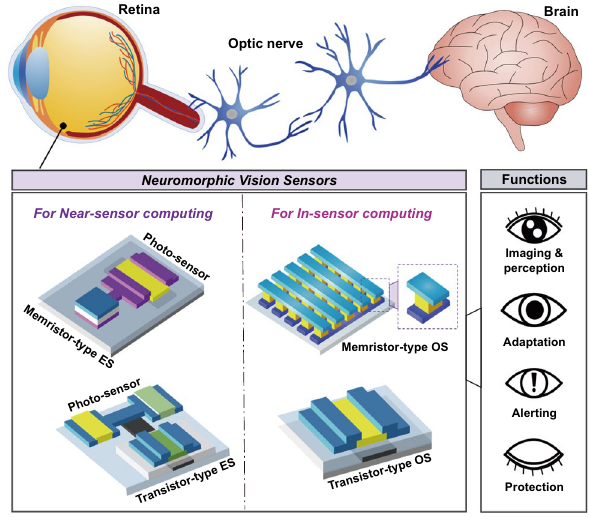
Fig. 2 Bio‑inspired neuromorphic vision sensors; optoelectronic syn‑ aptic circuits (OSCs) operating in near‑sensing computing manner and optoelectronic synapses (OSs) operating in in‑sensor computing